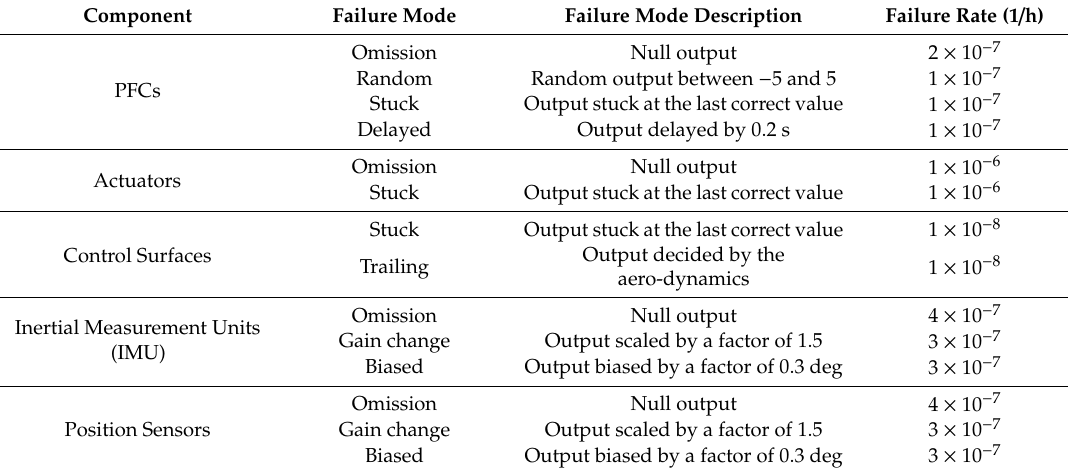
Table 1. Component failure modes of the fly-by-wire (FBW) system